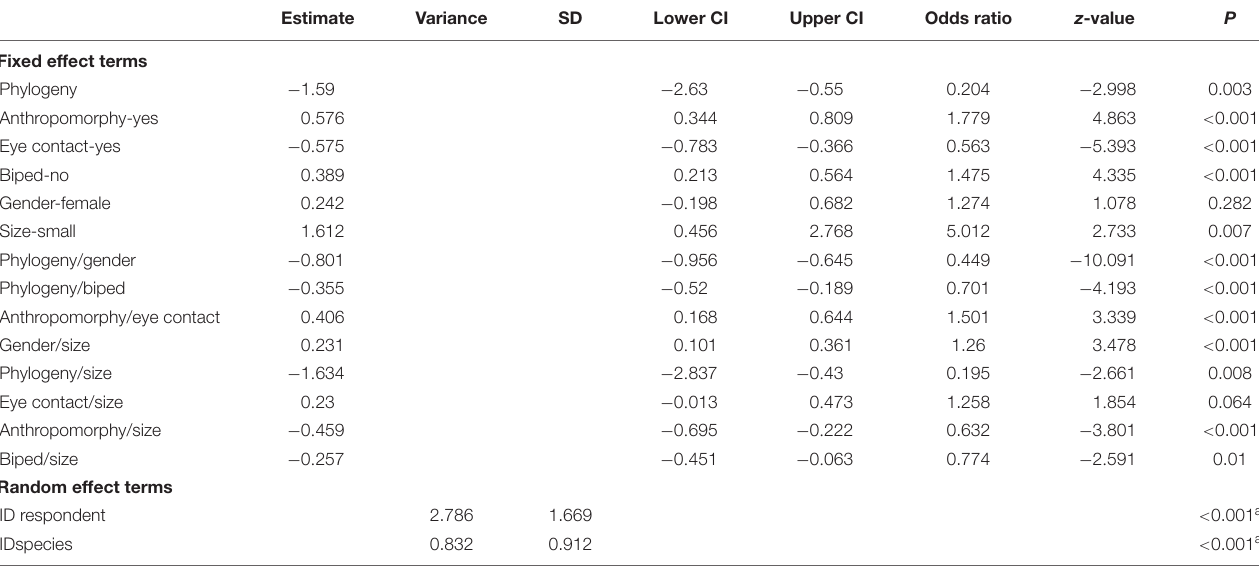
TABLE 3 | Results of the cumulative link mixed model on the respondent’s cuteness